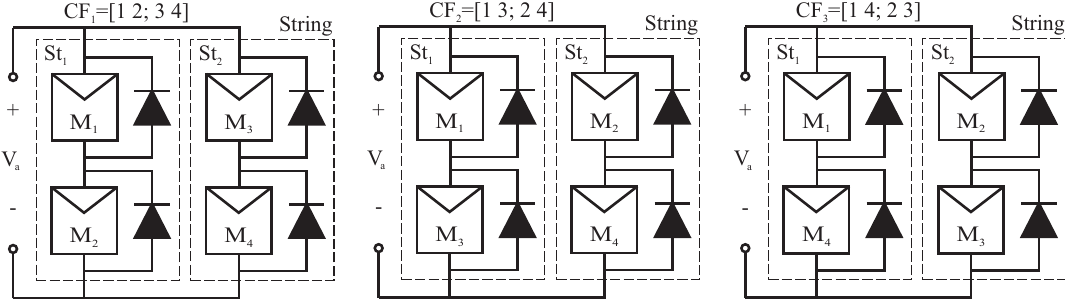
Figure 3. Possible configurations of a series-parallel (SP) array with two strings of two modules